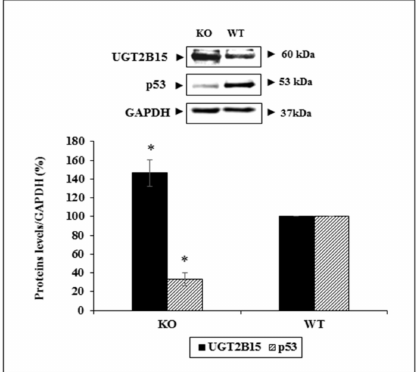
Figure 9. In vivo analysis of interactions between UGT2B15 and p53. Whole skin tissue was obtained from p53-KO and wild-type mice and processed as described in Materials and Methods. Levels of UGT2B15 and p53 were measured by Western blots. GAPDH served as a loading control. Bars represent the mean ± SD of two independent samples. * p < 0.01 vs. p53 wild-type